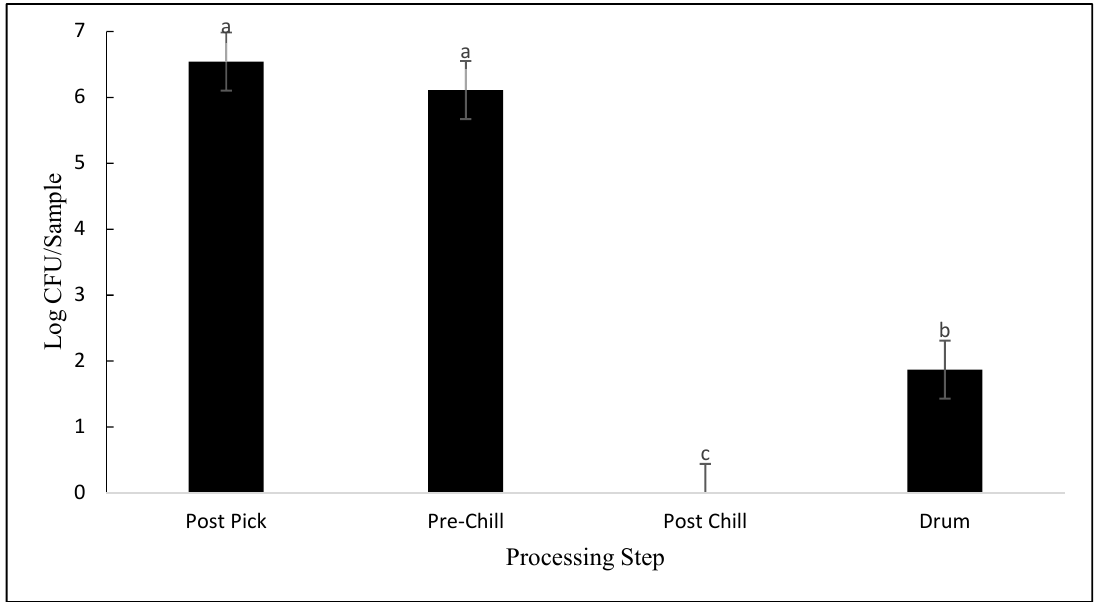
Figure 1. APC contamination expressed as log CFU/sample, detected from samples collected at post ‐ pick, pre ‐ chill, post ‐ chill, and drumsticks ( p < 0.001). Means with different letters differ statistically.